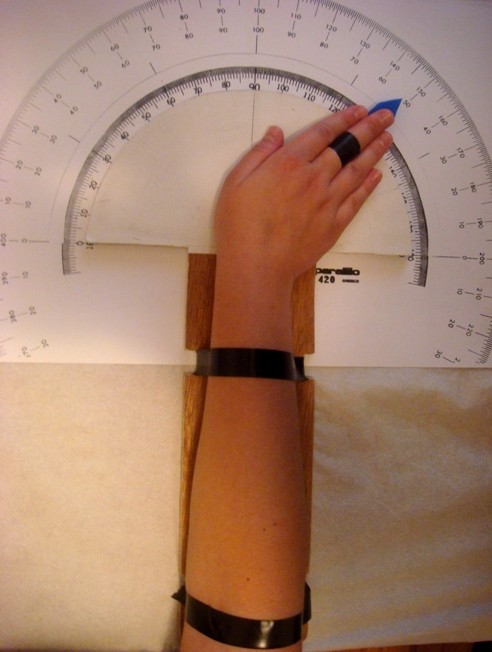
Right hand ulnar deviation.